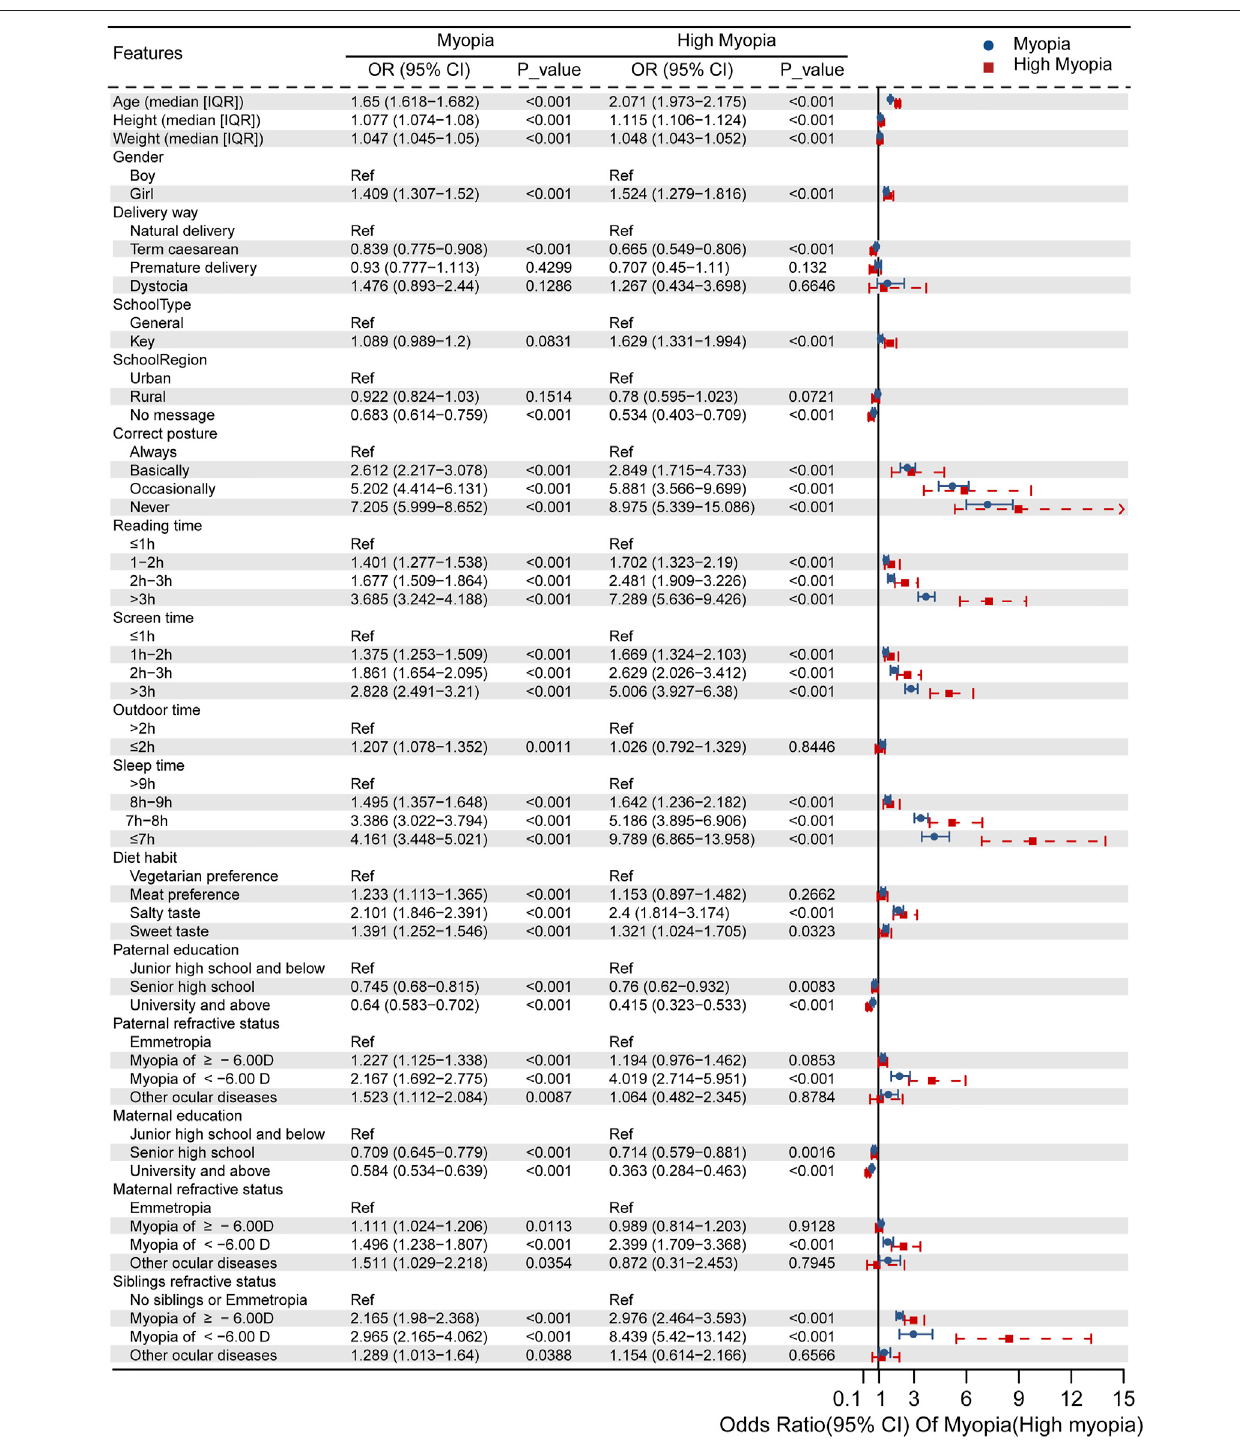
FIGURE 2 | Independent risk factors for myopia or high myopia evaluated via univariate regression